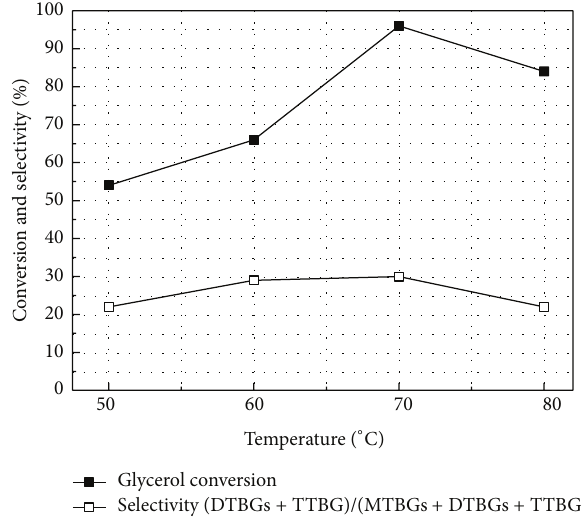
Figure 6: Influence of themolar ratio on the product yield. Reaction conditions: 70 ∘ C, Amberlyst 15 catalyst = 7.5 wt.% to glycerol, and 8 hours.